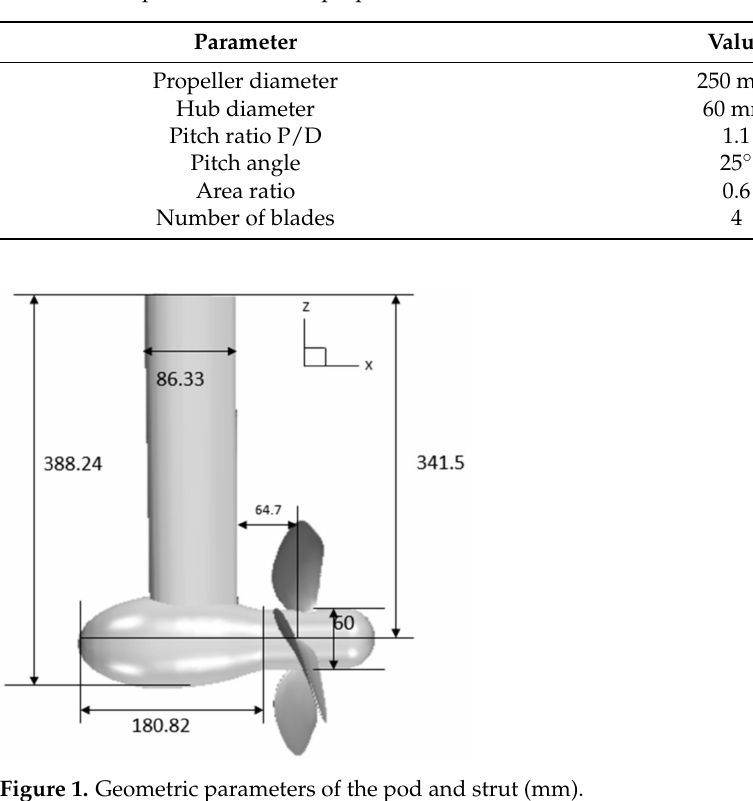
Figure 1. Geometric parameters of the pod and strut (mm).